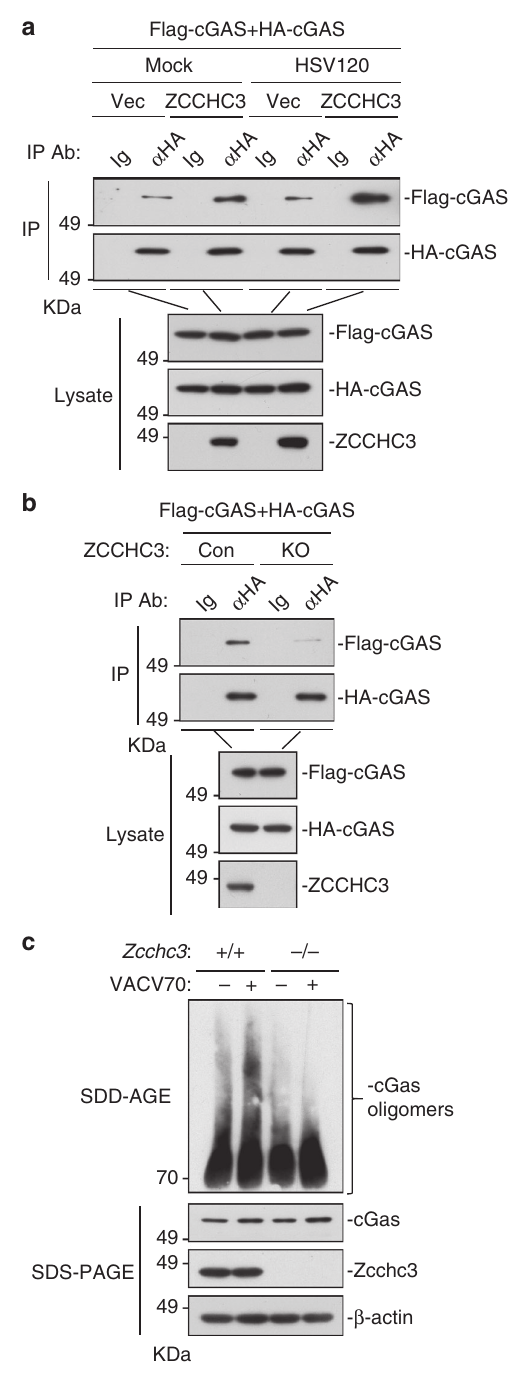
of Virology, CAS). HSV-1 (KOS strain), VACV (Tian-Tan Strain) and MCMV were purchased from China Center for Type Culture Collection. Constructs . Expression plasmids for HA-, FLAG-, or GFP-tagged ZCCHC3 and its truncation mutants, and HA-, FLAG-, or RFP-tagged cGAS and its truncation mutants were constructed by standard molecular biology techniques. Expression plasmids for HA-tagged MDA5, MITA, TBK1, and IRF3, and the IFN- β promoter reporter plasmids were previously described 30,41 – 44 . Preparations of primary mouse cells . For preparation of BMDMs, mouse bone marrow-derived monocytes (5 ×10 6 ) were cultured in 100-mm dishes in 5ml 10% M-CSF-containing conditional medium from L929 cells for 3 – 5 days. For